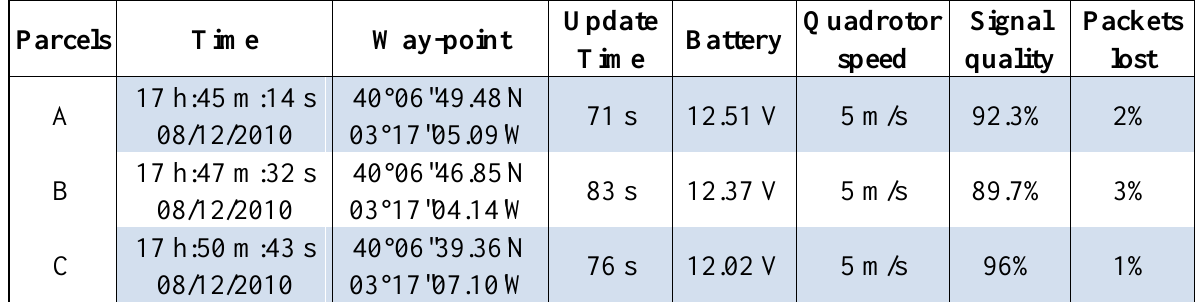
Table 3. Values from the aerial robot ( i.e. , dynamic node) survey